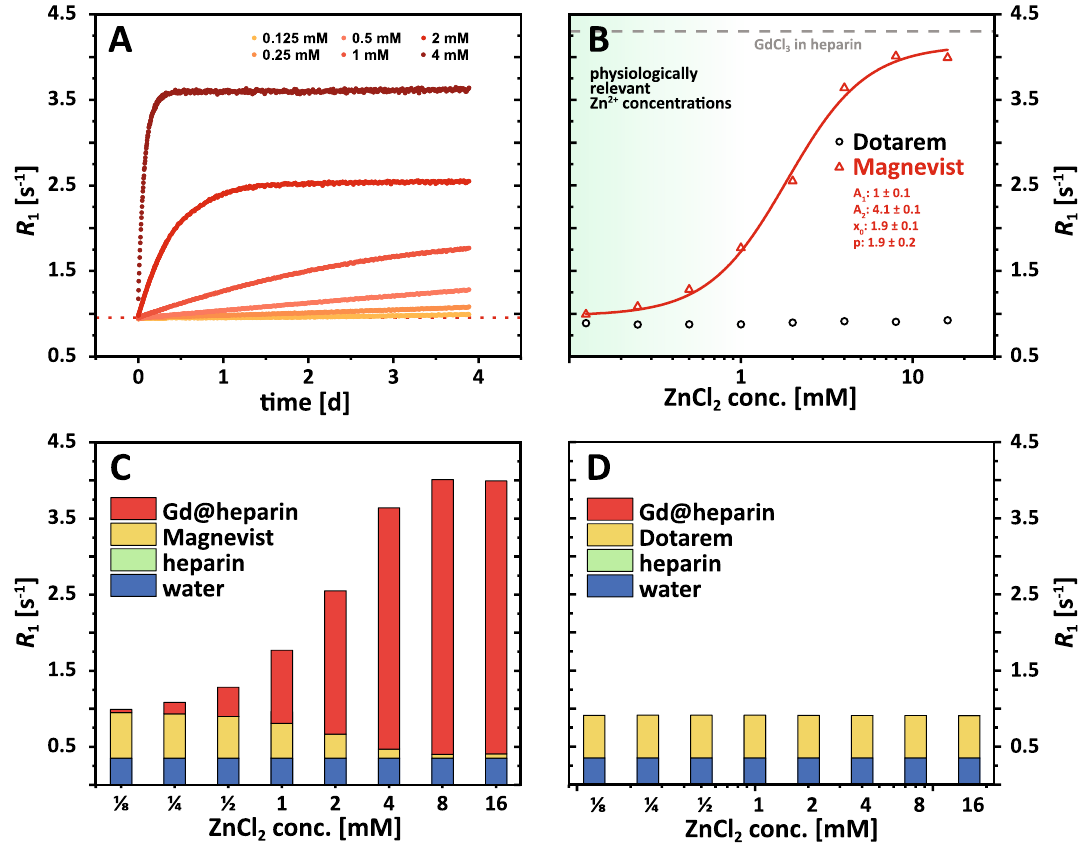
Figure 5. Results of transchelation experiments at 9.4 T and 25 °C. ( A ) Time-resolved R 1 relaxation rate measurements of 150 µM Magnevist in 100 µM heparin solution after the addition of different ZnCl 2 concentrations between 125 µM (yellow) and 4 mM (dark red). R 1 values increase after the addition of ZnCl 2 at time point 0 and reach new plateau values that increase with increasing [ZnCl 2 ]. The time constant for the observed transchelation process decreases from more than 21 days for [ZnCl 2 ] ≤ 0.5 mM to less than 2 h for [ZnCl function of [ZnCl 2 ] were observed for Dotarem. The red solid line represents the fit using a logistic function (fit results are displayed). The physiological range of Zn 2+ concentrations is labelled in green. ( C ) Bar charts of the individual contributions of water (blue), of the intact GBCA (yellow), of heparin (green), and of formed Gd-heparin complexes (red) to the overall observed relaxation rate of 150 µM Magnevist solution 5 days after the addition of different ZnCl 2 concentrations. ( D ) Same as ( C ) but for Dotarem instead of Magnevist.